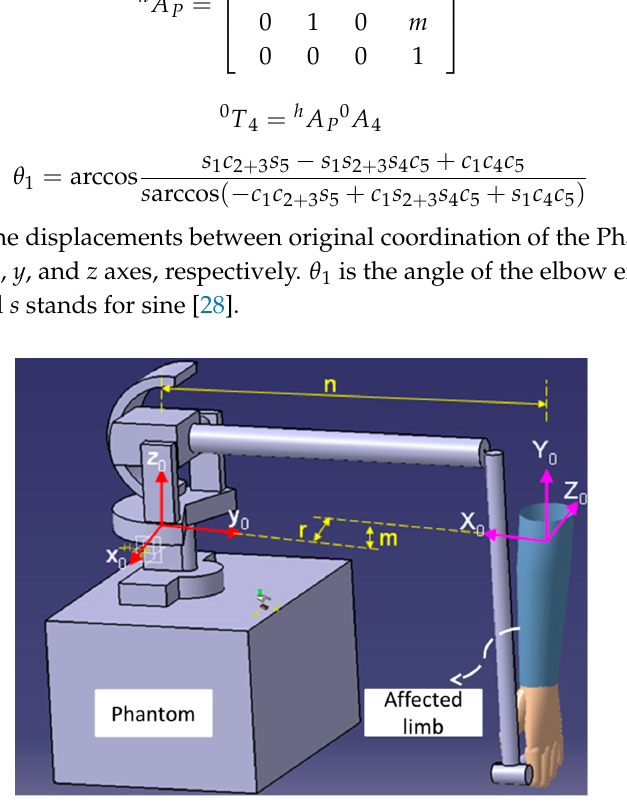
Figure 5. Frame assignment for the upper limb and the Phantom Premium.